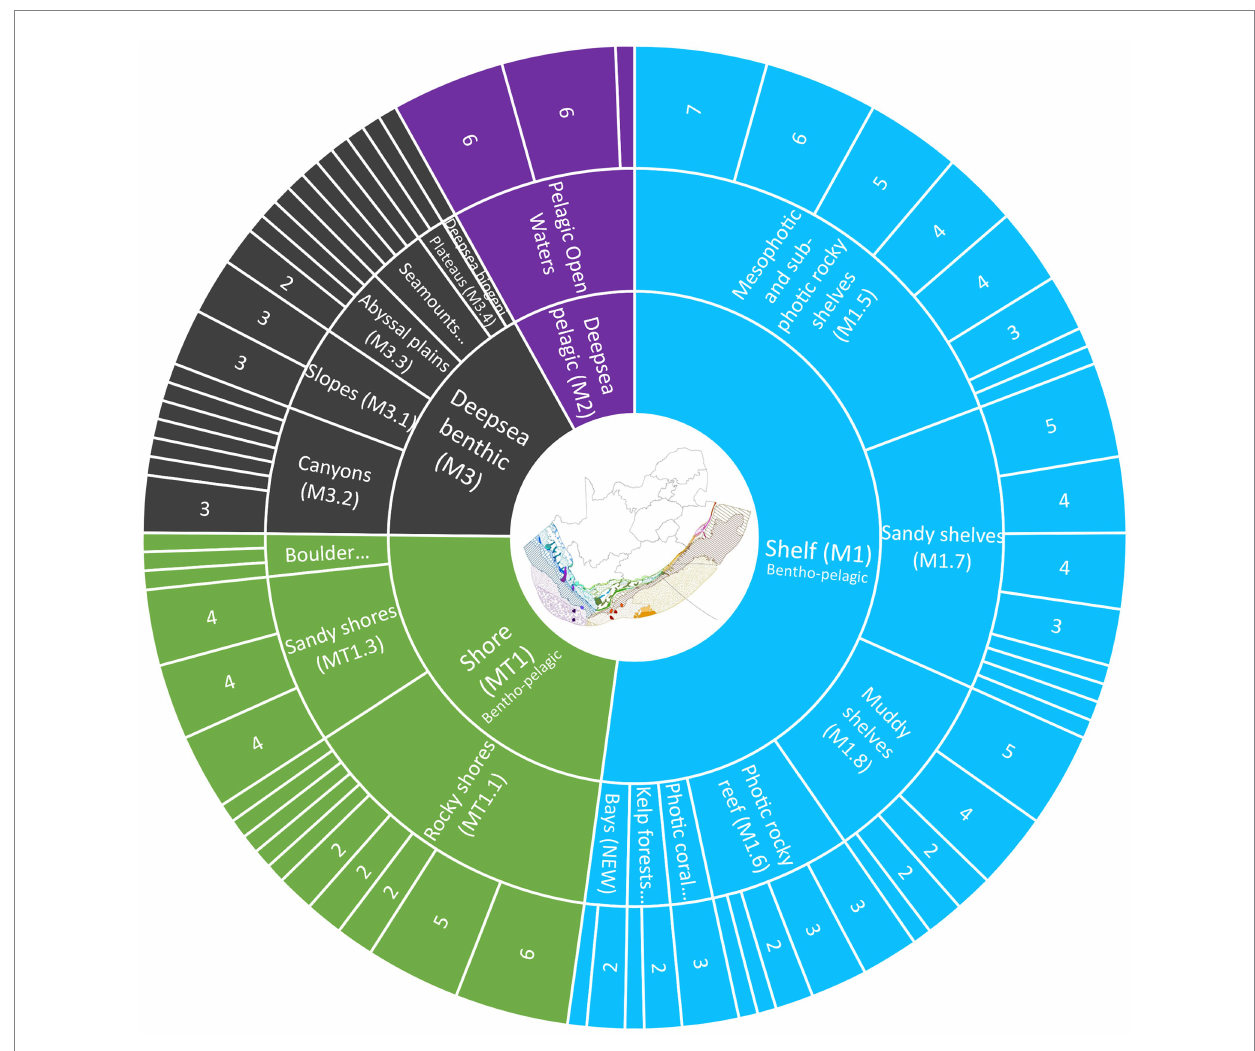
FIGURE 4 Overview of South Africa’s latest marine ecosystem classification with four bathomes (inner ring), 17 Ecosystem Functional Groups (central ring) nested within the four bathomes 58 biogeographic ecotypes (segments in outer ring) and 163 national marine ecosystem types (not shown as a distinct ring). The number and relative width of each segment in the outer ring reflects the number of national marine ecosystem types nested within each of the biogeographic ecotypes. Where there is no number, there is only one ecosystem type associated with that biogeographic ecotype. Note that the shore and shelf do not separate into benthic and pelagic components but the deepsea includes overlapping benthic and pelagic layers (see Table